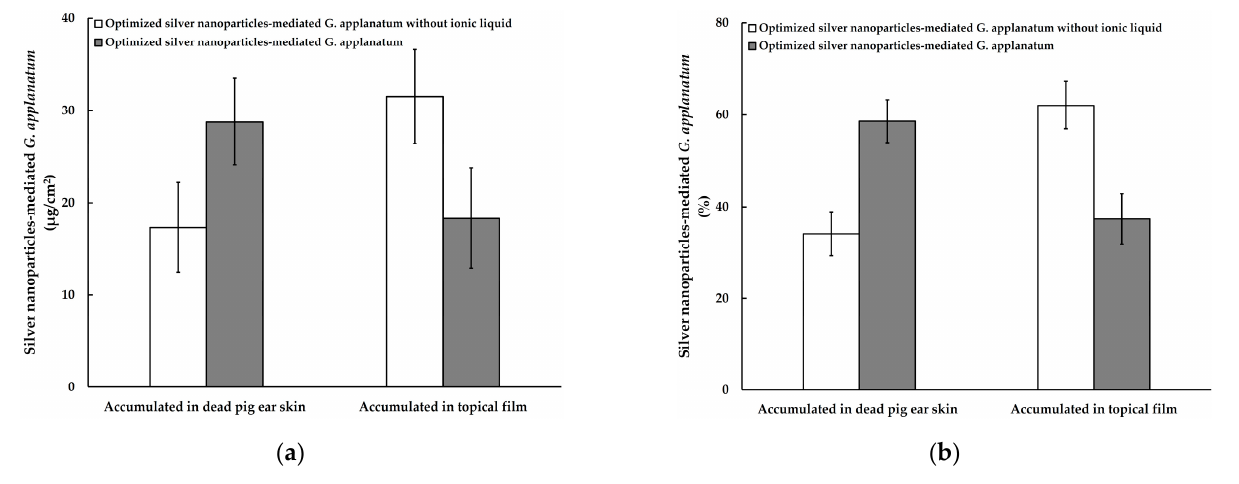
Figure 15. Silver-nanoparticle-complexed G. applanatum accumulation in dead pig ear skin and topical film: ( a ) content and ( b ) percentage of silver-nanoparticle-complexed G. applanatum .